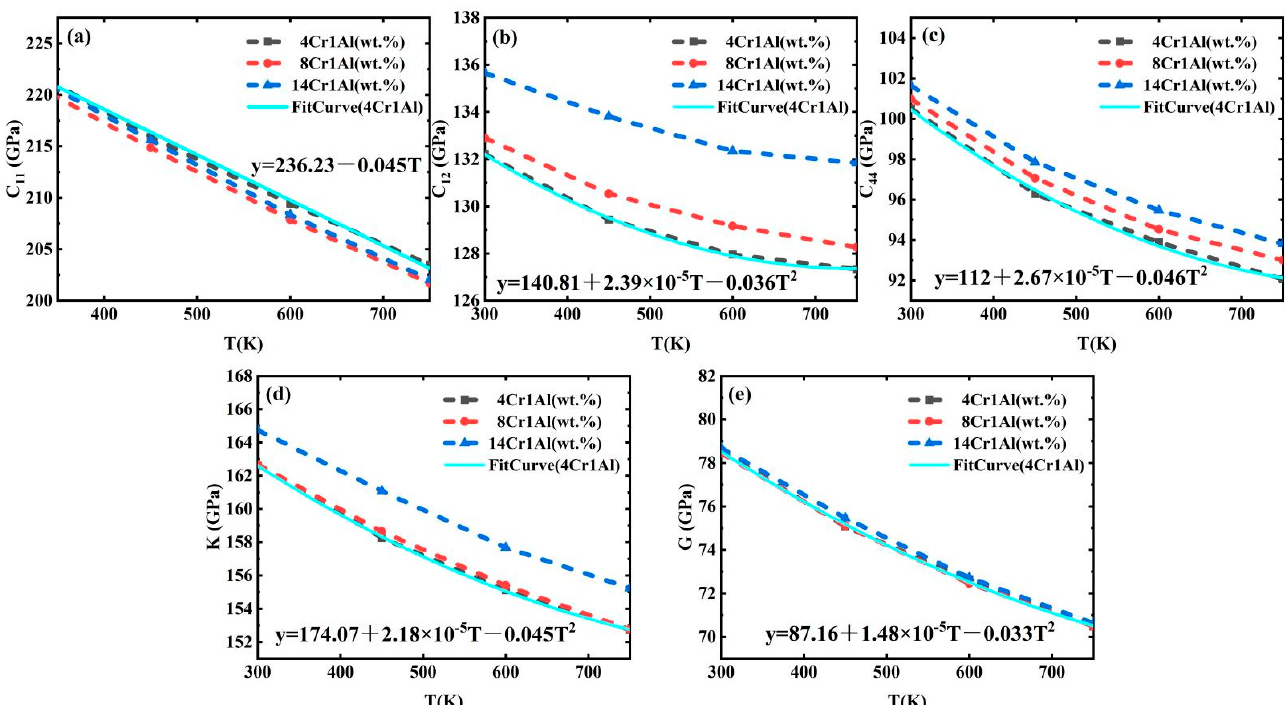
Figure 4. ( a – e ) Dependence of elastic constants, C 11 , C 12 , C 44 , bulk modulus and shear modulus on temperature for 4Cr1Al (wt.%), 8Cr1Al (wt.%) and 14Cr1Al (wt.%) compositions at 300–750 K. Table 2. Fitted parameter values in the models of elastic constants and modulus as a function of temperature for Fe4Cr1Al (wt.%), Fe8Cr1Al (wt.%) and Fe14Cr1Al (wt.%). The models are given in Equations (1) and (2). Fe4Cr1Al(wt.%)